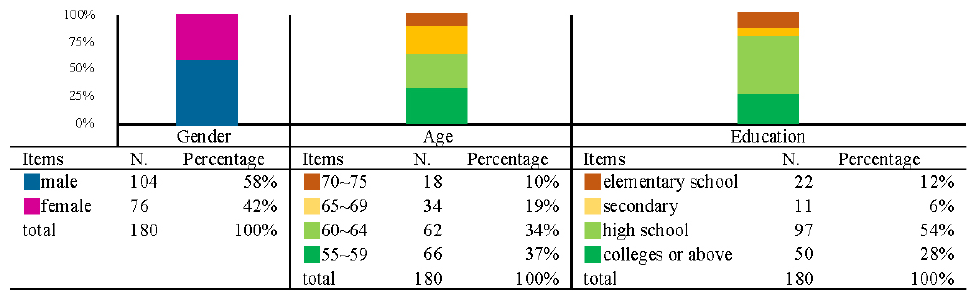
Figure 5. Descriptive statistical results of participants’ gender, age, and education.